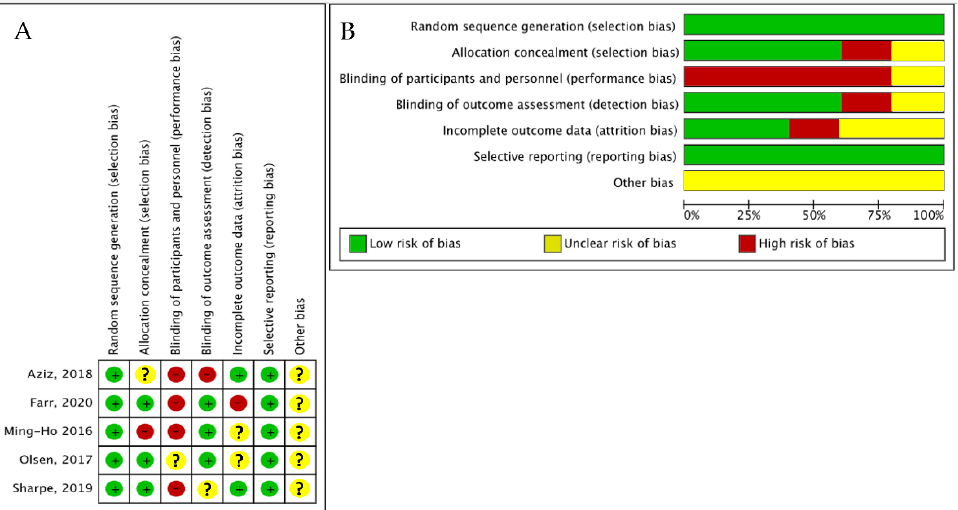
Figure 2. Assessment of bias risk. ( A ) Summary of risk of bias for each trial. A plus sign indicates a low risk of bias; a minus sign indicates a high risk of bias; a question mark indicates an unclear risk